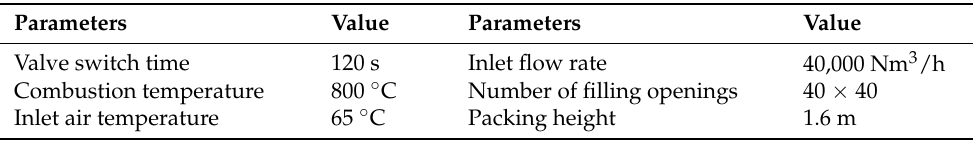
Table 6. Parameters of the benchmark